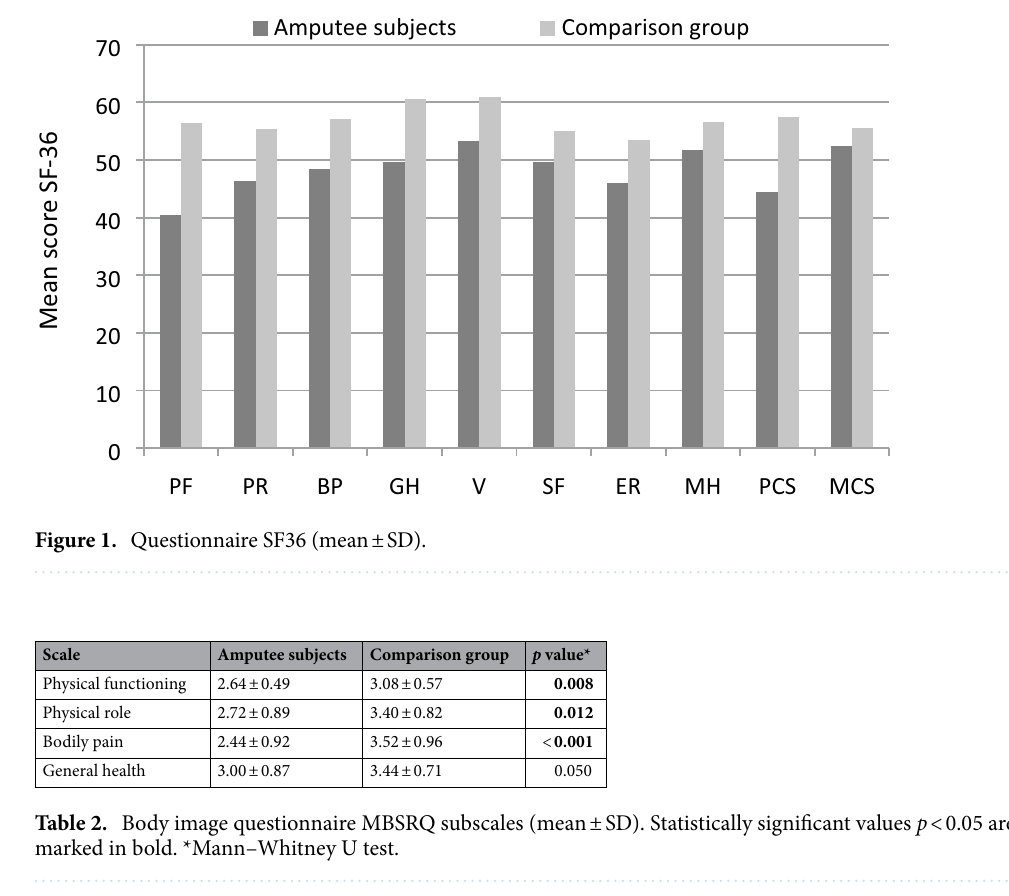
Table 2. Body image questionnaire MBSRQ subscales (mean ± SD). Statistically significant values p < 0.05 are marked in bold. *Mann–Whitney U test.